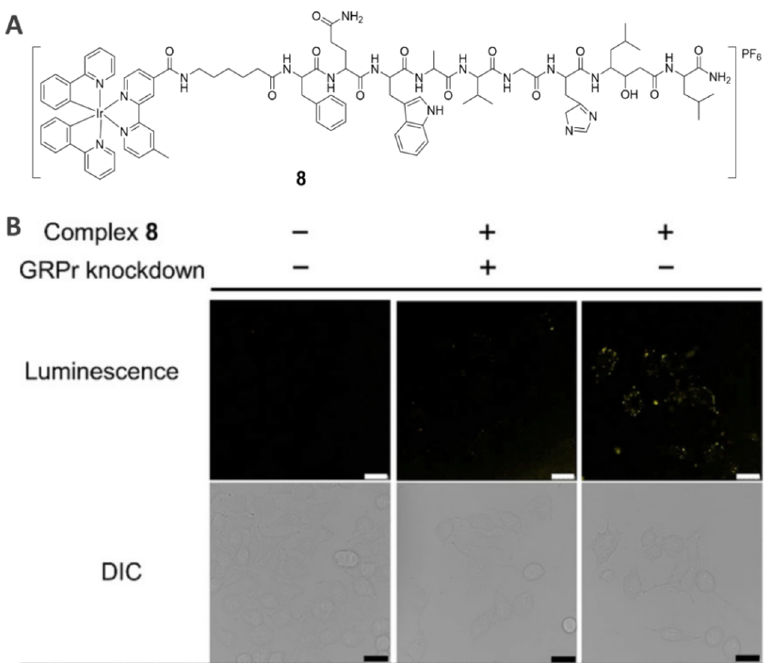
Figure 7. ( A ) Chemical structure of complex 8 . ( B ) Effect of GRPr knockdown on the imaging of A549 cells. A549 cells and GRPr knockdown A549 cells were incubated with or without complex 8 (10 μM) for 2 h. Cell images were detected at λ exc /λ emi = 405/570−690 nm. Reproduced with permission from ref. [61]. Copyright 2020 John Wiley and Sons.